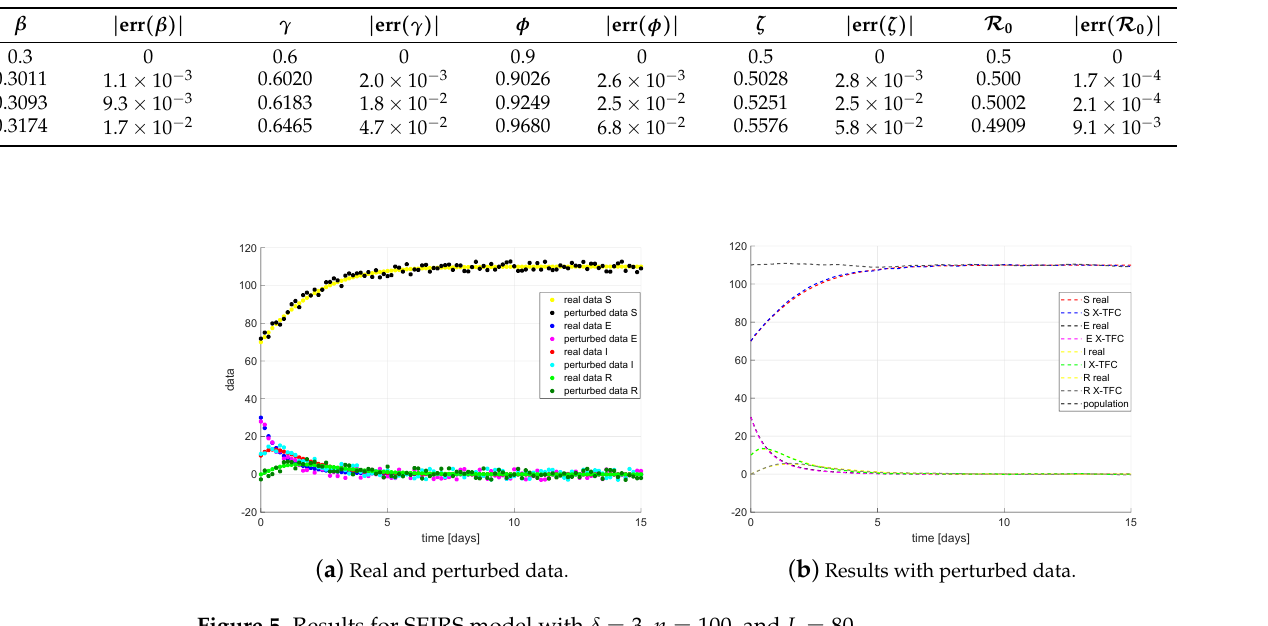
Figure 5. Results for SEIRS model with δ = 3, n = 100, and L =